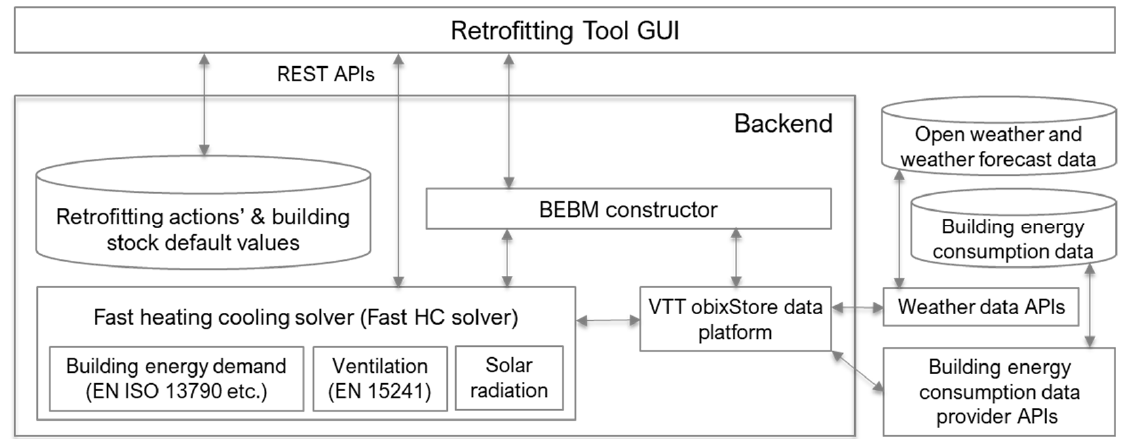
Figure 1. The retrofitting decision support tool architecture.